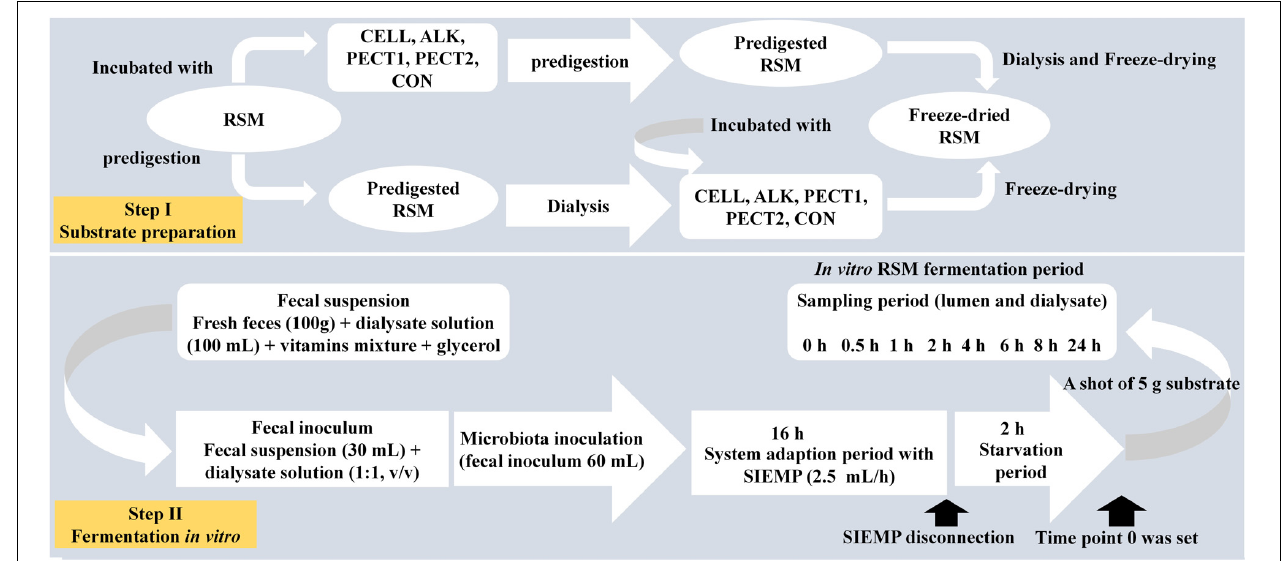
FIGURE 1 | Schematic experimental setup for fiber fermentation in the Swine Large Intestine in vitro model (SLIM).